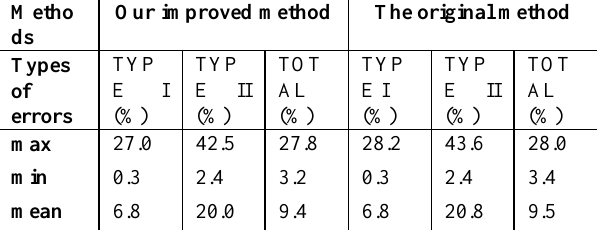
Table 1. Comparison between the two filters using feature points and 3D-edges.